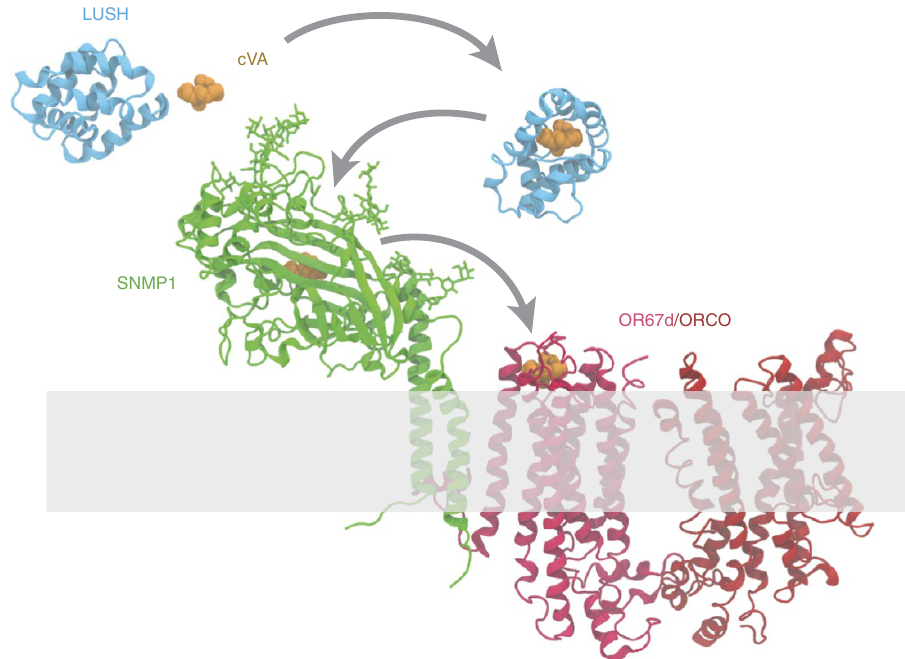
Figure 9 | Model for cVA detection. A pheromone molecule is first encapsulated by the OBP LUSH in the extracellular lymph. Direct or indirect interaction of cVA/LUSH with SNMP1 leads to release of the pheromone molecule and its transfer via the ectodomain tunnel in SNMP1 to the ligand-binding site within the OR67d/ORCO complex. Apo and cVA-bound LUSH structures are from X-ray crystals (PBD 1T14 (ref. 71) and PDB 2GTE (ref. 39), respectively). The SNMP1 model is the protein homology model shown in Fig. 8, in which N- and C-terminal sequences encoding the transmembrane helices have been added by de novo protein folding. The OR67d/ORCO complex is represented as an arbitrarily arranged dimer of a generic OR protein model (OR85b (model 140_12), ORCO (model 310_2)) generated by de novo protein folding based on co-evolutionary couplings 53 ; the stoichiometry and arrangement of this complex in vivo is unknown. The cilia membrane is represented by a transparent grey